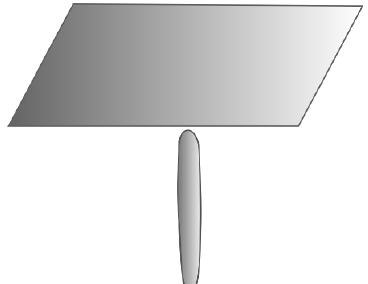
Figure 18 . One possible outcome of evolving the state in (cid:12)gure 17(b) further in time is a topological phase transition where the region inside the horizon is disconnected from the